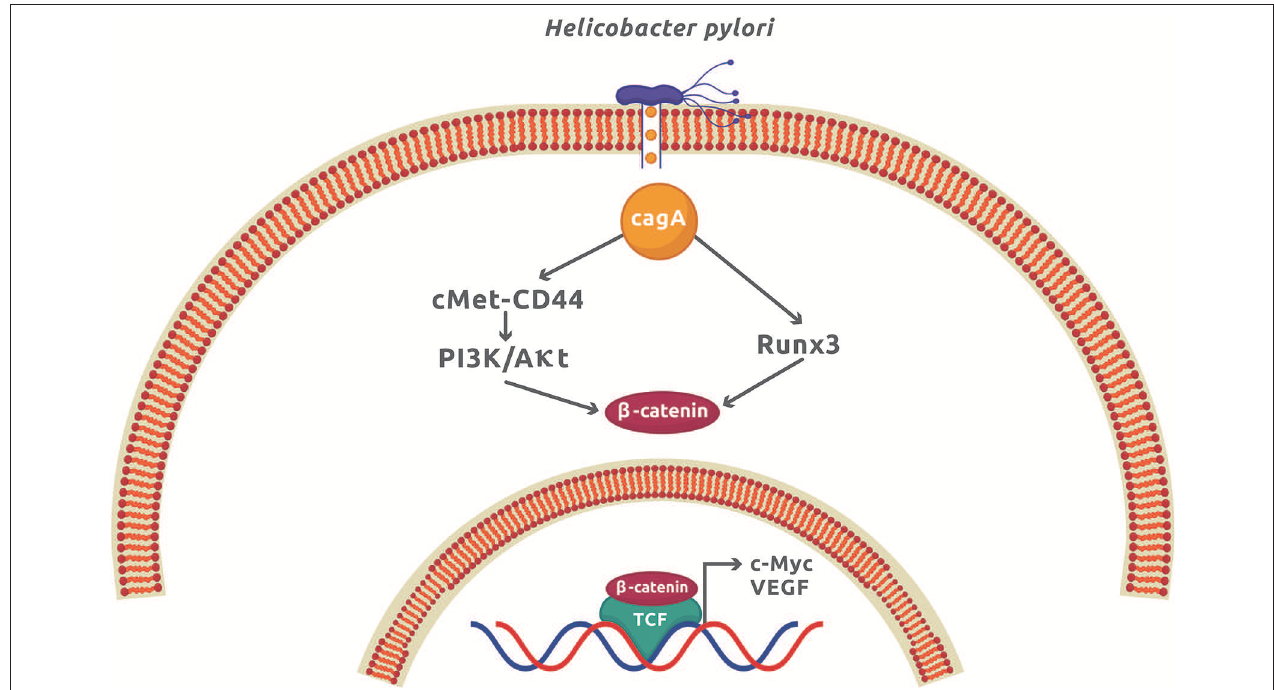
FIGURE 3 | The CagA virulence factor from Helicobacter pylori promotes gastric cancer by activation of the Wnt/ β -catenin signaling. Once CagA enters the cytoplasm by injection through the type 4 secretion system, it forms a molecular complex with c-Met and CD44, which activates the PI3K/Akt signaling. CagA also interacts with Runx3, which promotes its ubiquitination and proteasome degradation. These two CagA-dependent mechanisms, along with others independent of CagA described in the text, produces a net increment of cytoplasmic β -catenin and expression of β -catenin-dependent genes.